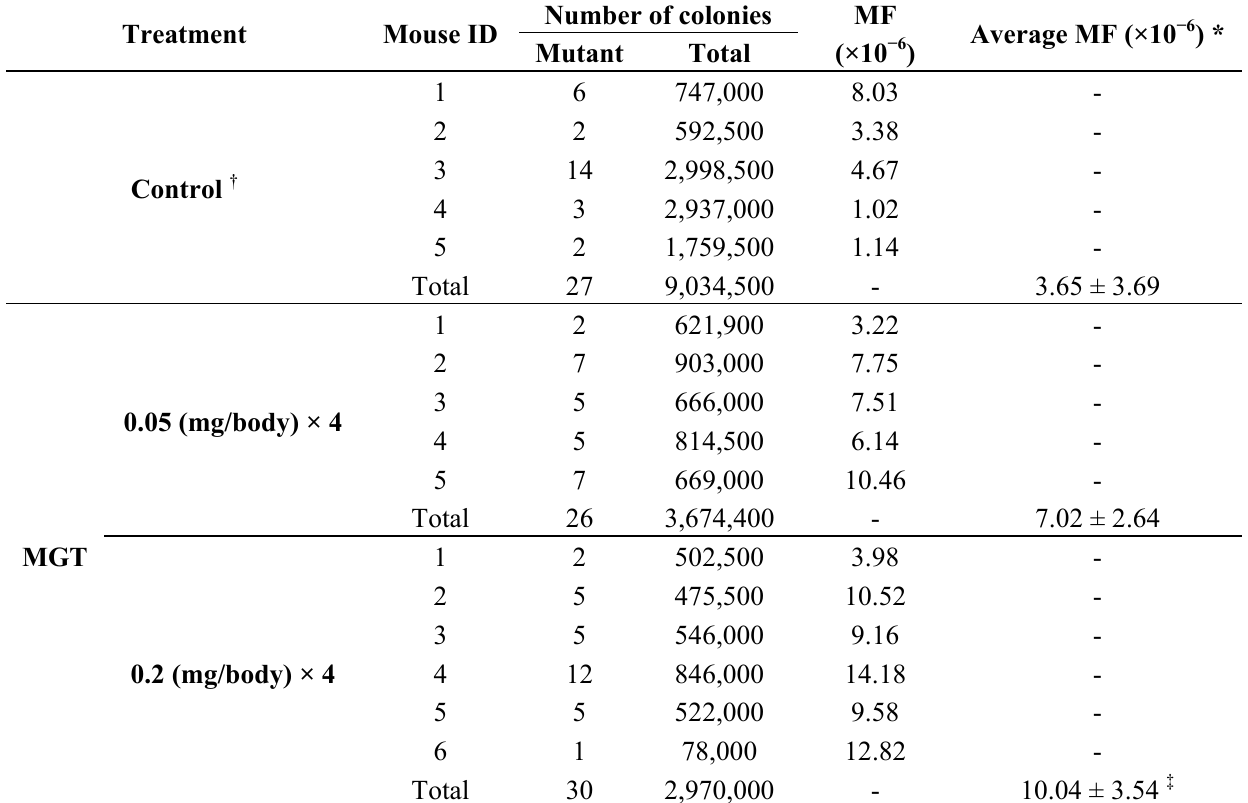
Table 1. Summary of mutant frequency (MF) in the lungs of gpt delta mice treated with MGT. Treatment Mouse